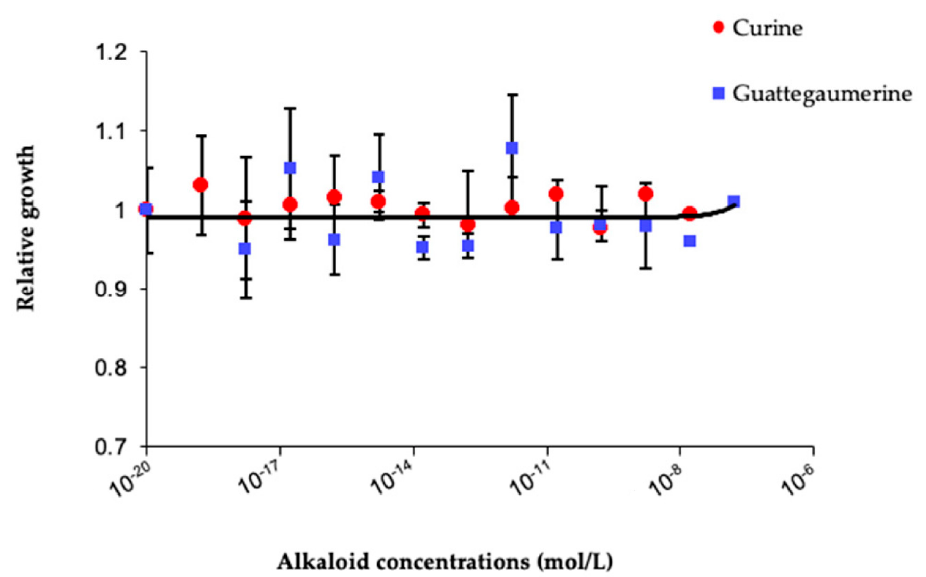
Figure 1. Structures of alkaloids used in this study. Curine and guattegaumerine were purified from the crushed roots of Isolona hexaloba. The structure of guattegaumerine was resolved through acetylation of the compound to give triacetylguattegaumerine. Verapamil was of commercial origin (Sigma). Therefore, the effects of curine and guattegaumerine on P. aeruginosa bacterial growth were investigated. To explore these effects, two strains were used: one non-mucoid from a collection of cultures (strain IP104116) and the other typical mucoid isolated from the lung of a patient with cystic fibrosis (strain NK125502). As shown in Figure 2, curine and guattegaumerine did not inhibit bacteria growth in a range of concentrations from 1 × 10 − 19 M to 1 × 10 − 6 M.